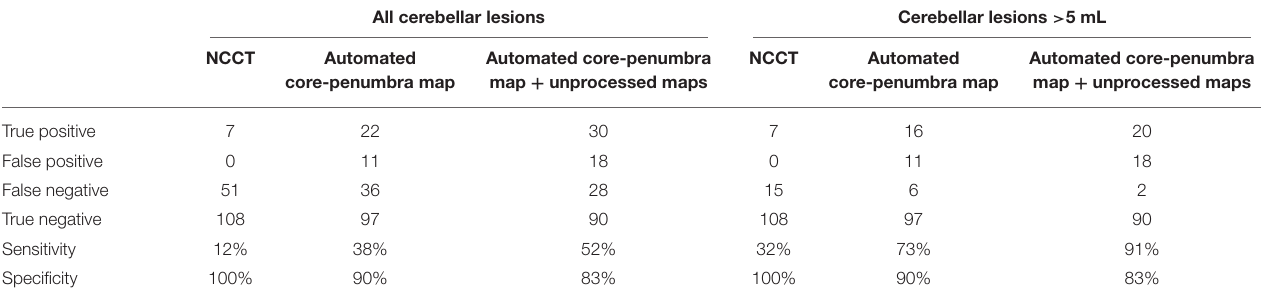
TABLE 2 | Sensitivity and specificity for cerebellar lesions with different imaging modalities. All cerebellar